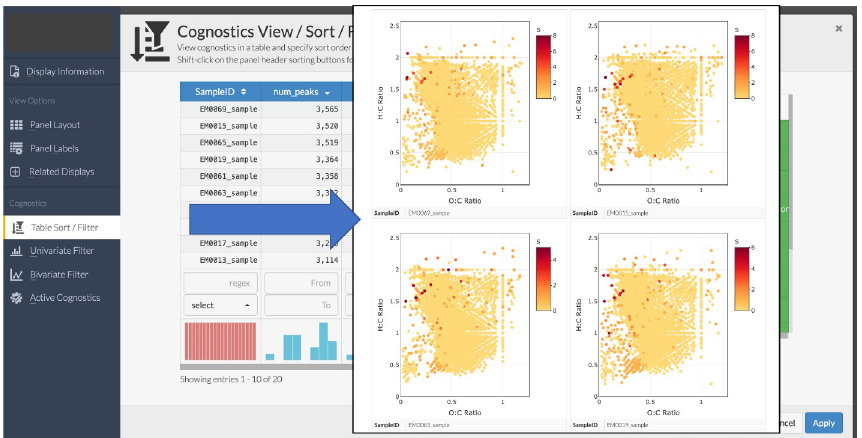
Fig 5. Screenshot of a Trelliscope display showing a van Krevelen plot for each sample. The left image shows the sort/filter capability, with which characteristics of each sample (e.g. number of observed formulae) can be used to order plots. The right image shows the first page of 2x2 plots of individual samples ordered by number of observed compounds and colored by number of S atoms.